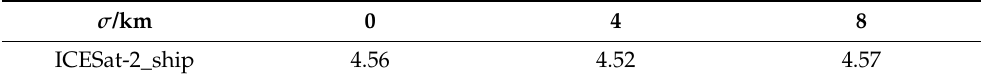
Table 7. STD of differences between gravity anomalies derived by different Gaussian filter windows and NCEI ship-borne gravity anomalies (Unit: